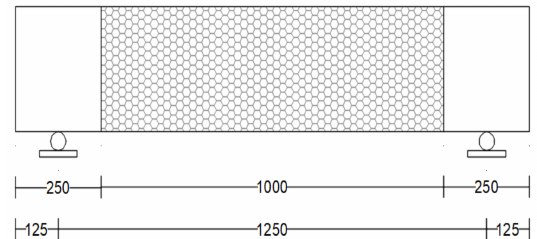
Figure 4. Beam B3-GFRP.